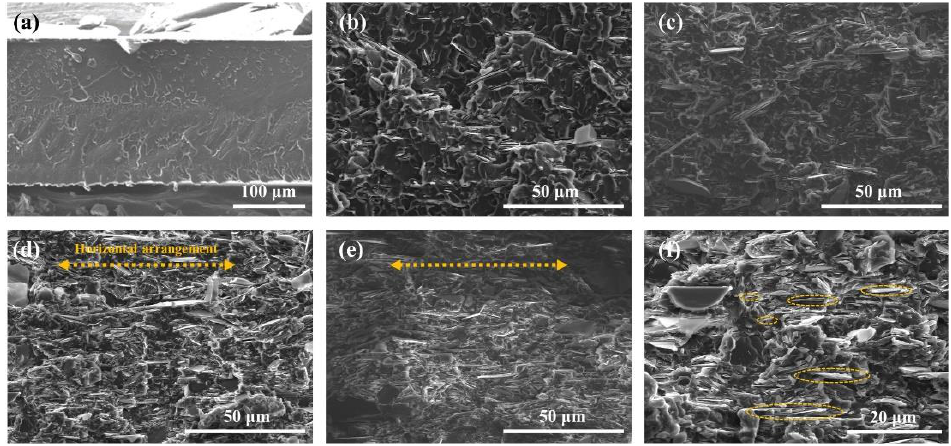
Figure 5. Cross-section SEM images of ( a ) PEI, ( b ) the 5 wt%, ( c ) 10 wt%, ( d ) 20 wt%, and ( e ) 30 wt% SABM-BN/PEI composite film. ( f ) Filler distribution at high magnification for the 20 wt% SABM-BN/PEI composite film.